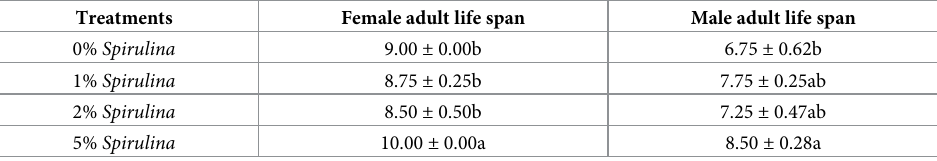
Means followed by the same letters within each column do not differ significantly (P <